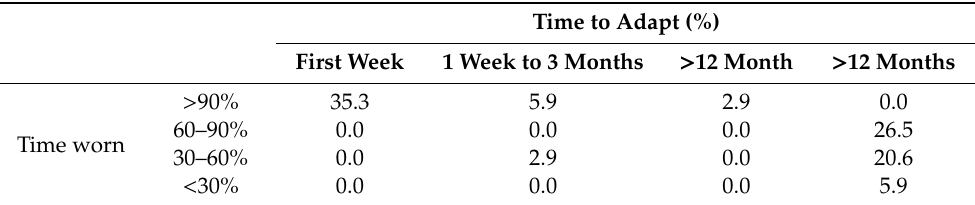
Table 6. Cross tabulation of self-reported adaptation and hearing aid use ( n = 34).